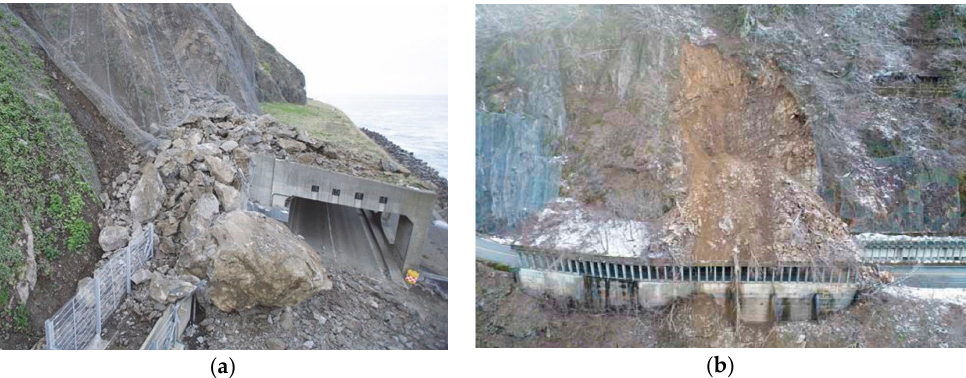
Figure 1. Examples of rockfall and landslide disaster; ( a ) Rockfall in a coastal area (Hokkaido, Japan, 2008), ( b ) Landslide in a mountainous area (Ishikawa, Japan, 2018).